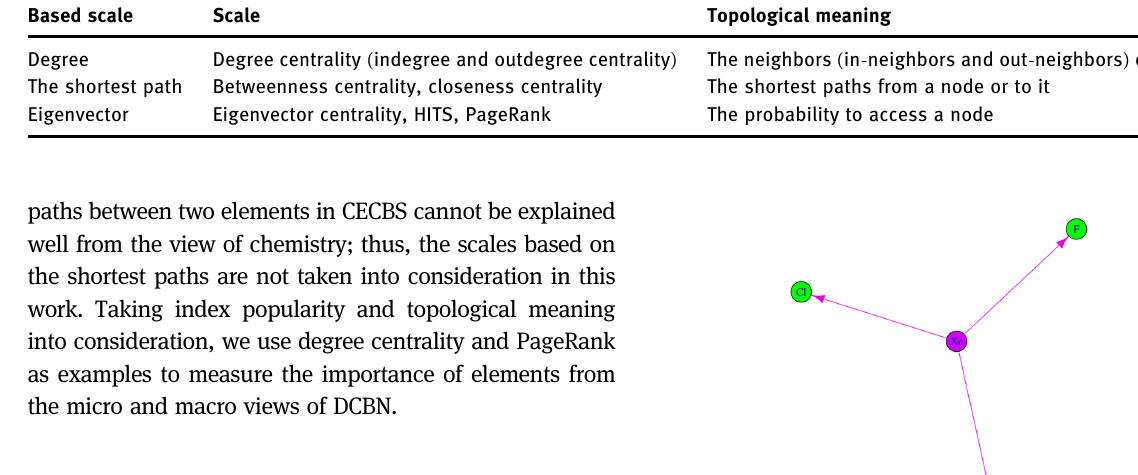
Table 1: Centrality scales in directed networks Based scale